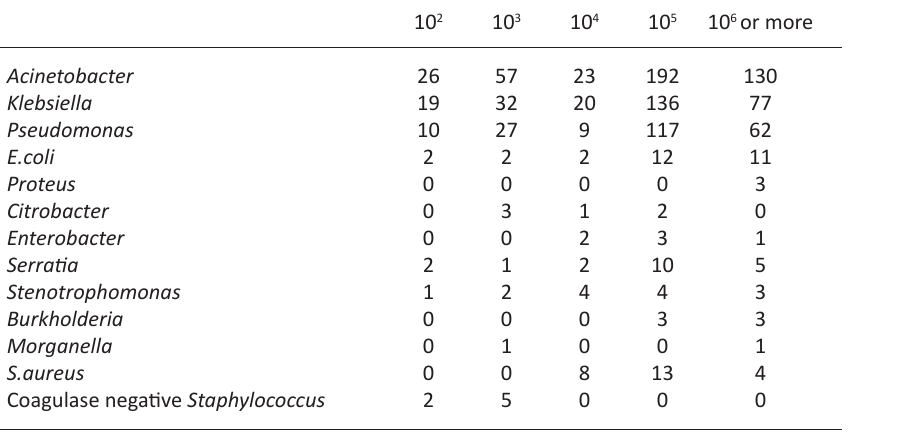
Table 1. Distribution of microbial isolates in colony forming units per ml